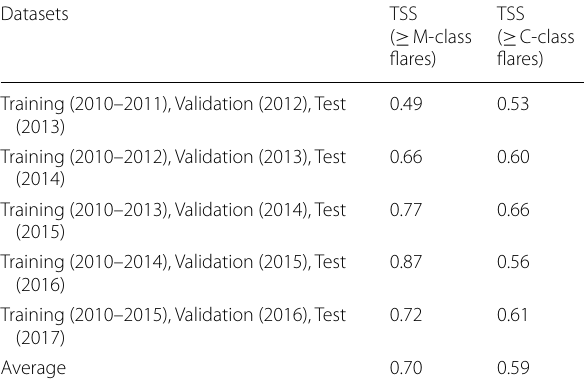
Table 4 Evaluation of DeFN forecasts using the time-series CV